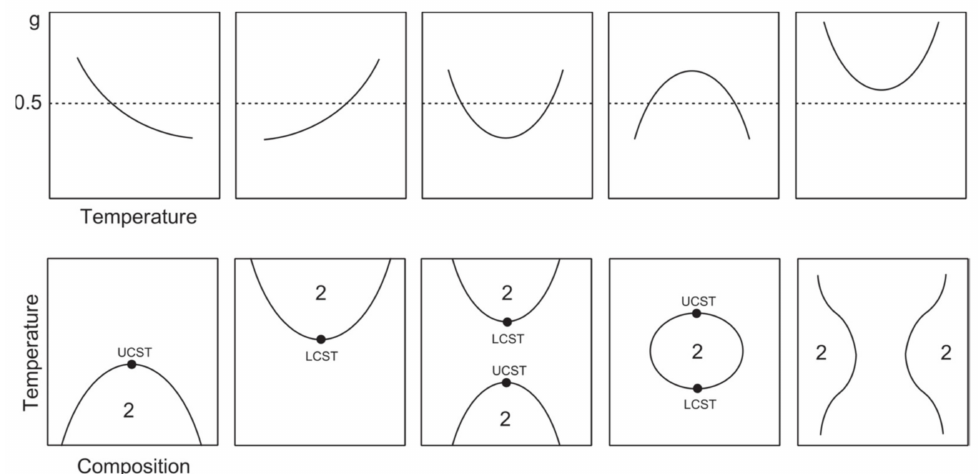
Figure 5. Correlation between the temperature dependence of the interaction parameter g and the type of miscibility gap. The number 2 indicates the presence of a two-phase region. Reprinted with permission from [99], copyright 2012, John Wiley and Sons.